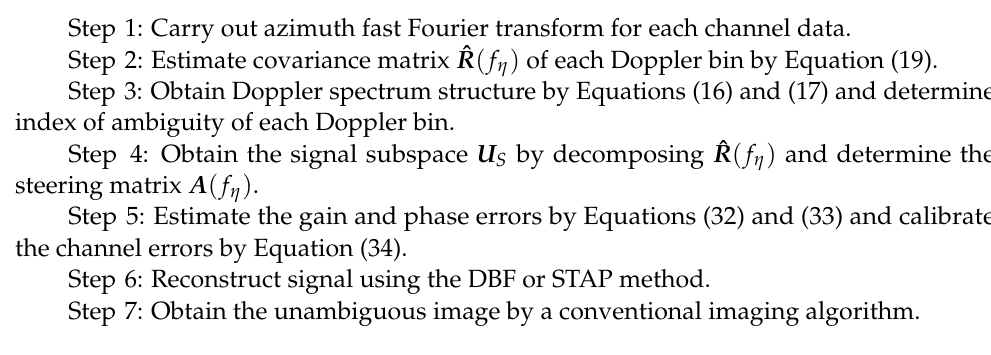
Figure 4. Flow–chart of the proposed estimation